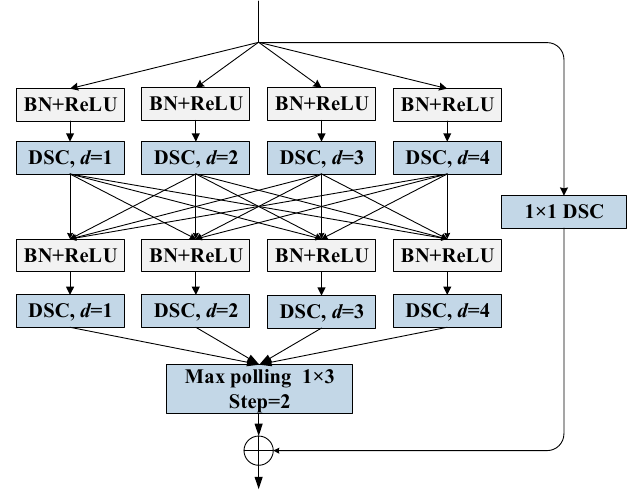
Figure 5. Architecture of the MsDCFU.